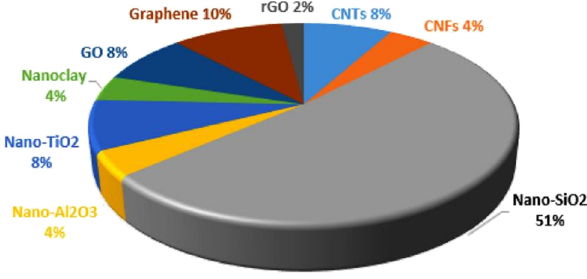
Figure 2: Research on the use of various nanomaterials in geopo - lymers [ 26 ]